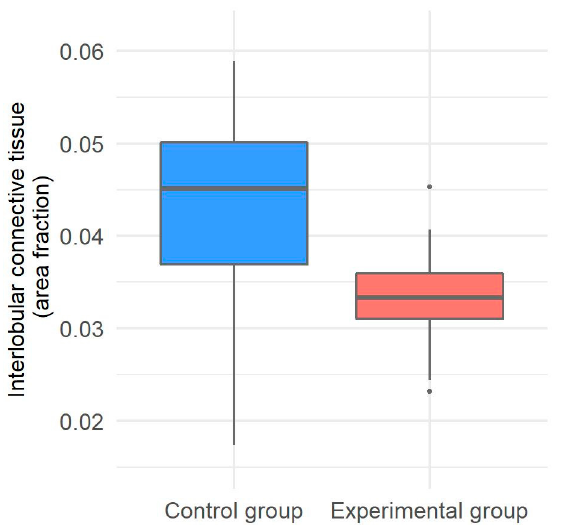
Figure 4. Distribution of interlobular connective tissue in the liver of the control and experimental groups of gilts with a statistically significant difference.